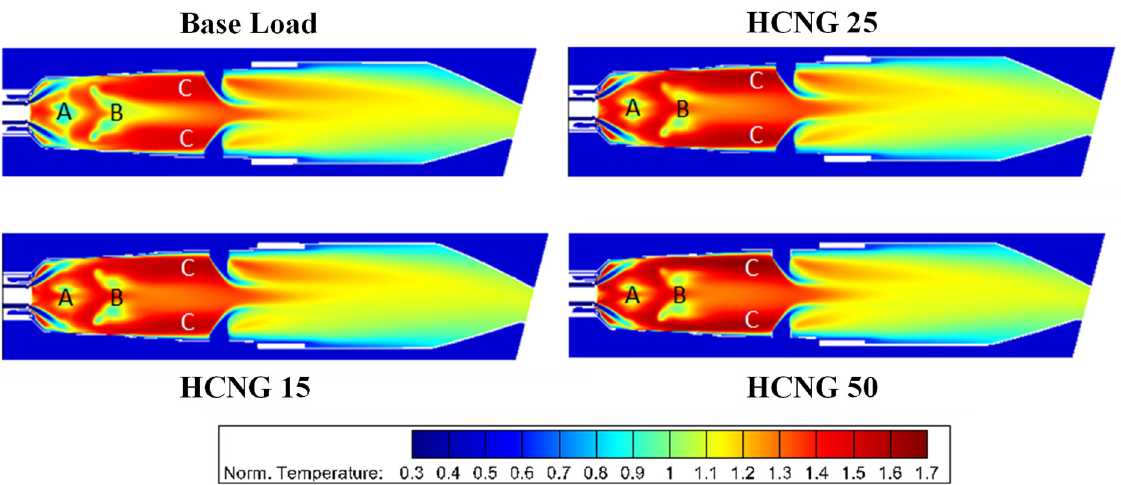
Figure 13. Normalized temperature contours—slice 1. Letters A–C denote specific regions as explained in the text.